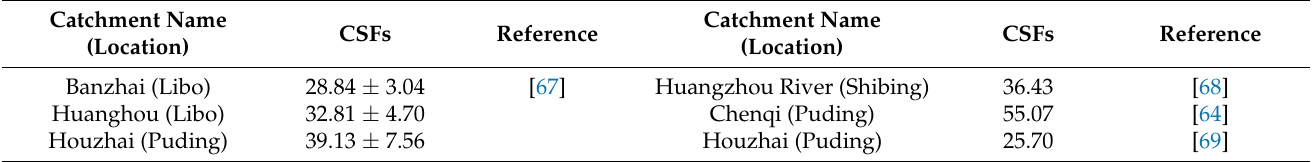
Table 2. Carbon sink fluxes (CSFs, tCO 2 km − 2 y − 1 ) from several different karst